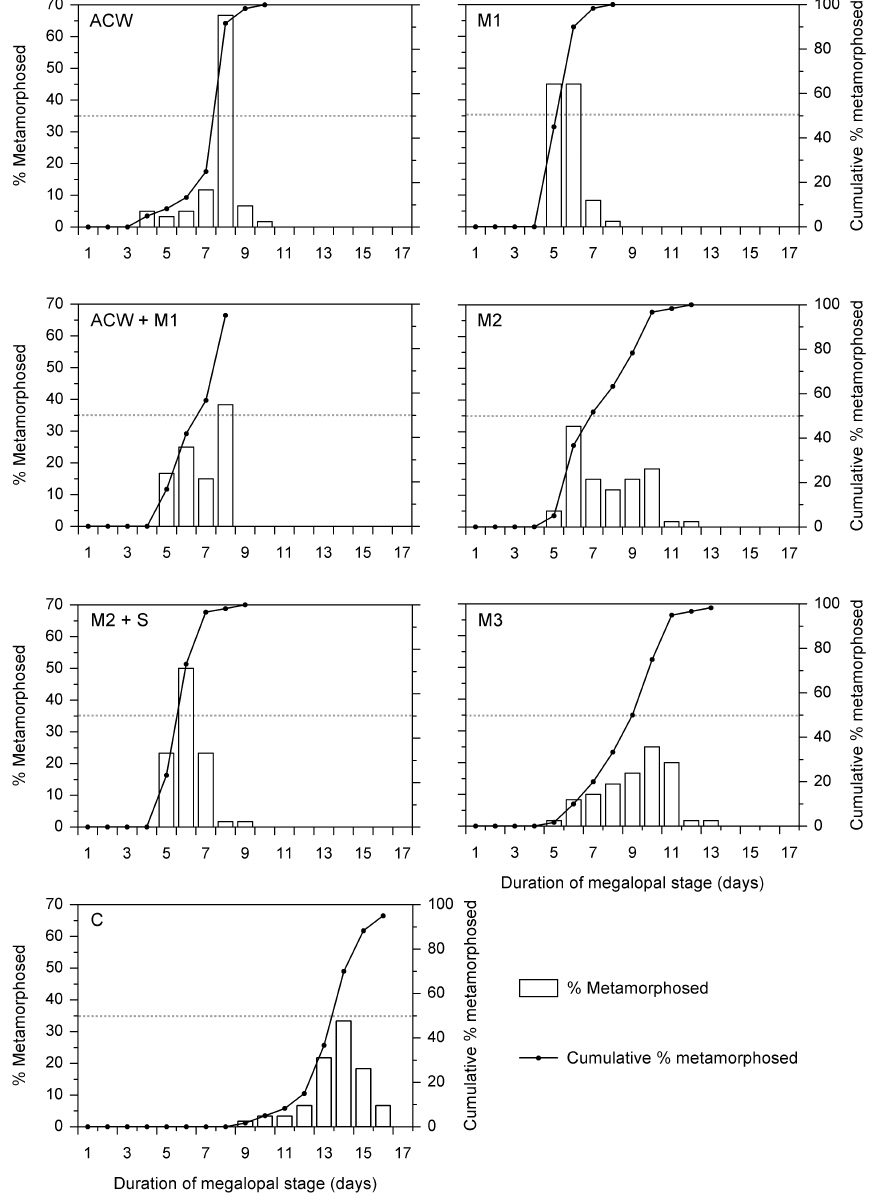
Fig. 1 – Percentage of metamorphosed U. vocator megalopae in the treatments with natural settlement cues from different mangrove habitats (well-preserved and degraded habitats), with adult-conditioned seawater and filtered pure seawater. Pooled data from three replicate vials. See Table I for abbreviations. Dashed lines indicate